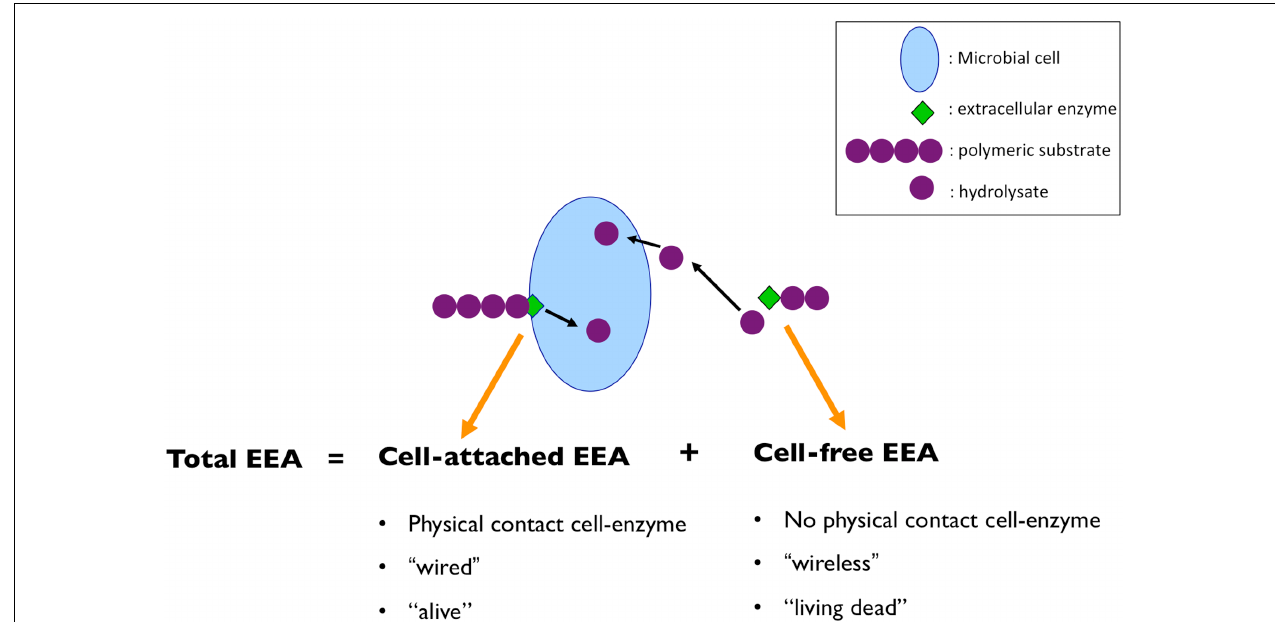
FIGURE 1 | Total extracellular enzymatic activity (EEA) is the result of the combination of cell-associated and cell-free enzymes. Using the analogy of internet connection; cell-bound EEA would be the equivalent of a “wired” connection, whereas cell-free EEA would be a “wireless” connection. Moreover, the cell-bound EEA will be closely linked to the living cell’s behavior, whereas the cell-free enzymes will not necessarily be related to the factors affecting the microbial cells that originally produced them, and will remain active for a prolonged period of time, away from the cell. Thus, using another analogy, we could say that the cell-attached EEA would be more closely related to an “alive” activity, whereas cell-free EEA would be in the “living dead”